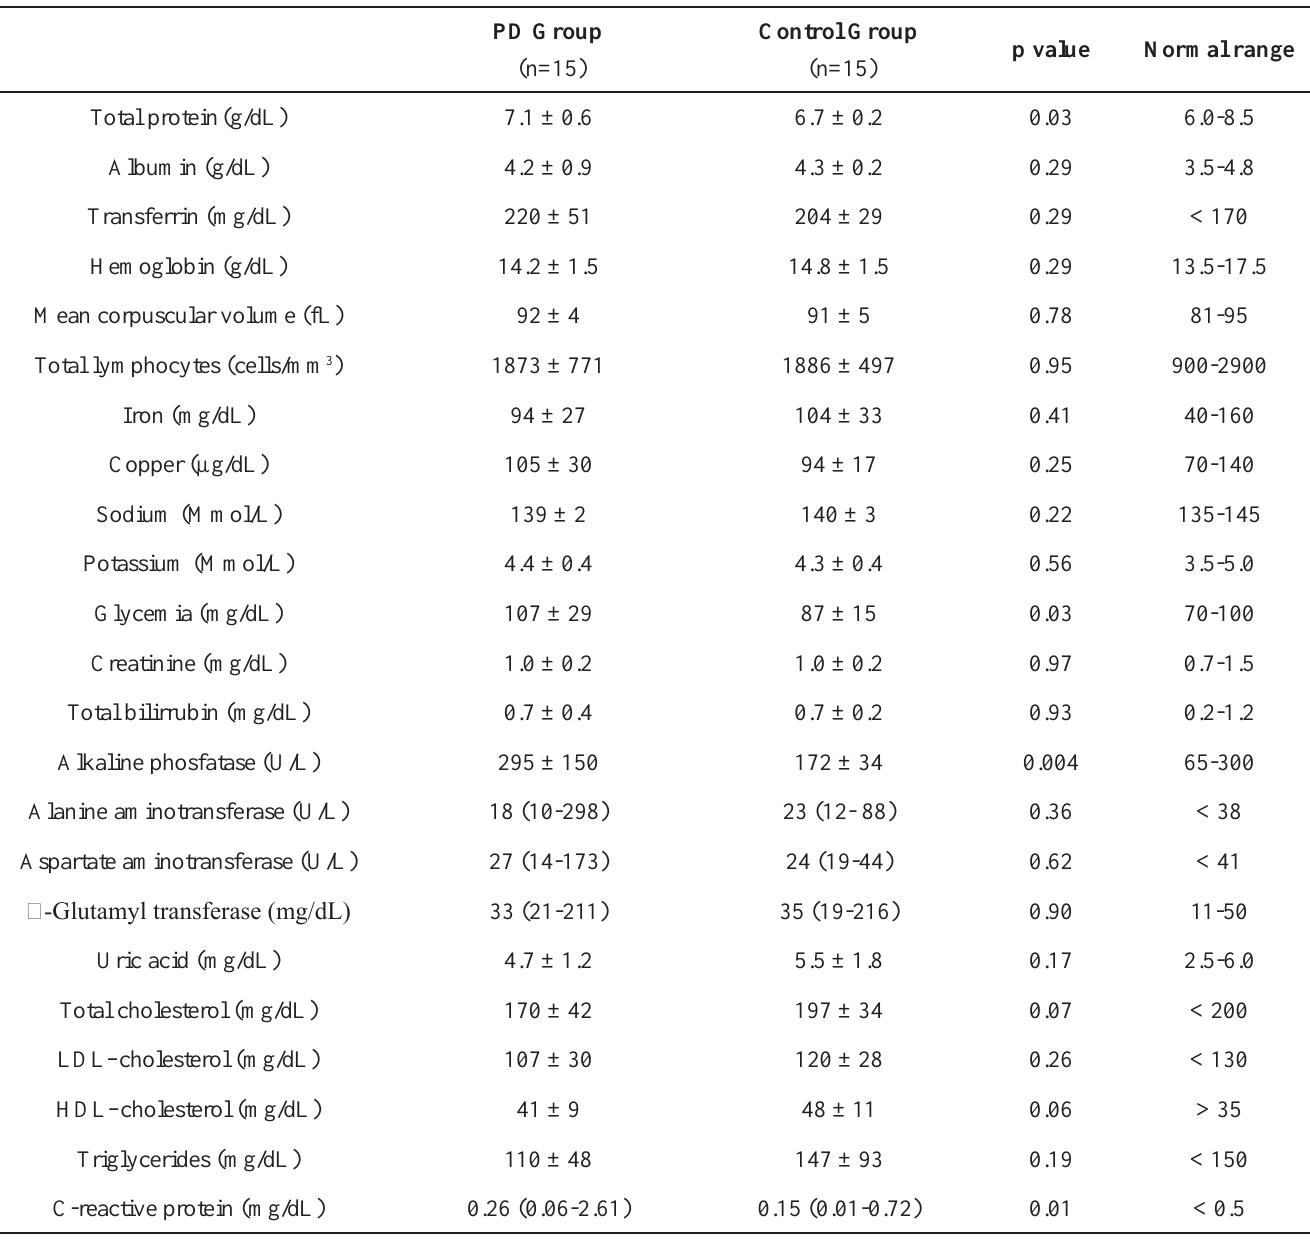
TABLE 2 - Clinical and nutritional laboratory data in the PD and Control